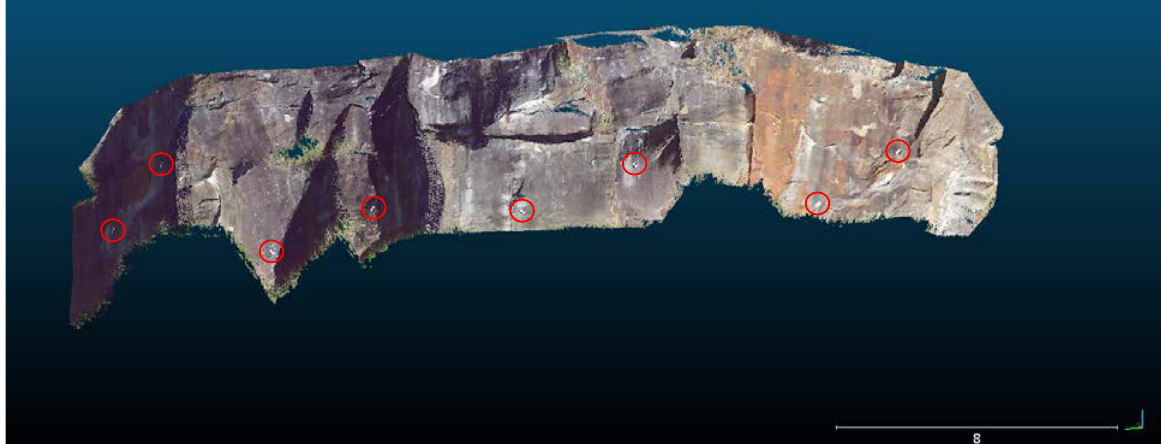
Figure 2. Reference model obtained with the TLS and locations of the eight GCPs (red circles)